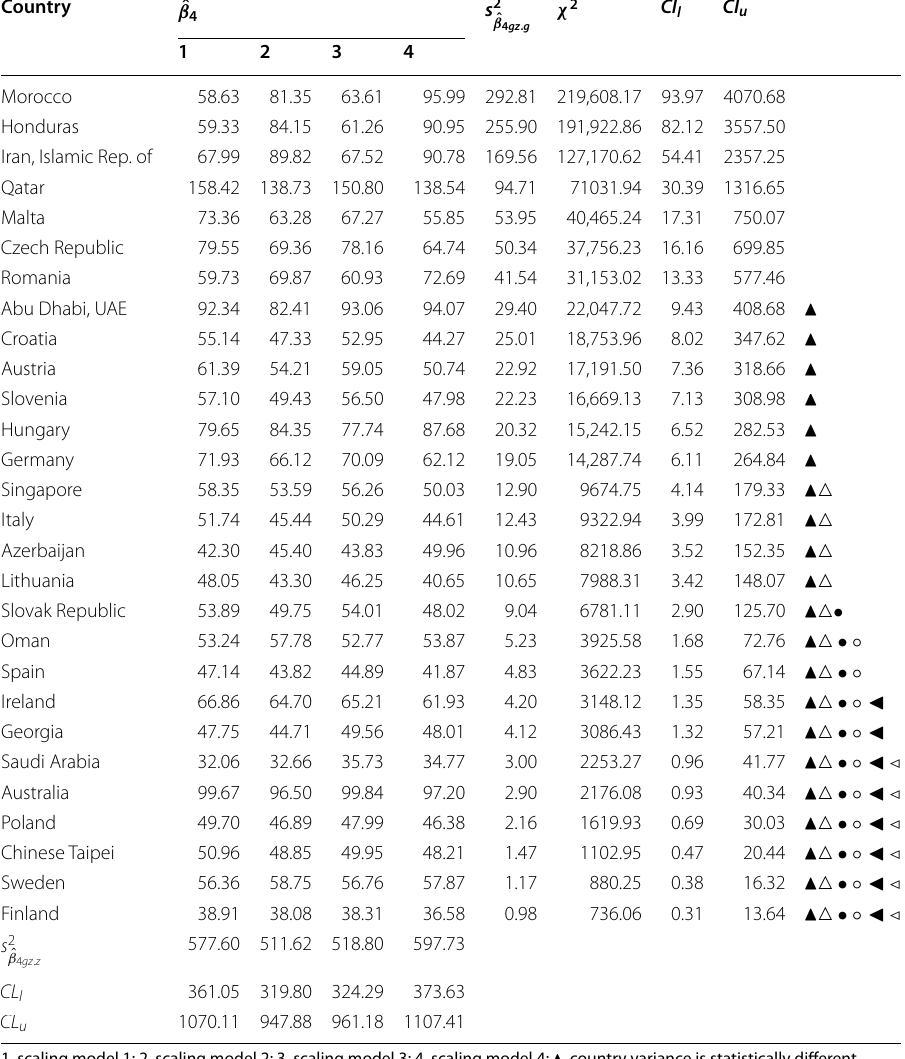
Table 9 Distribution of ˆ β 4 across scaling models and countries, χ 2 -value and asymmetric confidence interval ( CI l lower bound, CI u upper bound; countries ordered in descending order of the conditional variance of ˆ β 4 across scaling models given country g )